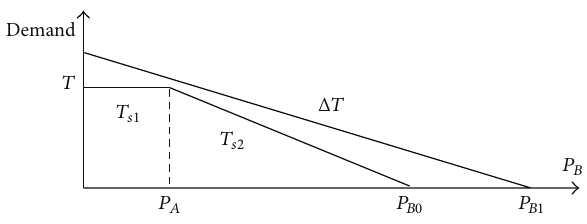
Figure 2: The changes of 𝑇 𝑠 and Δ𝑇 with the variety of 𝑃 𝐵